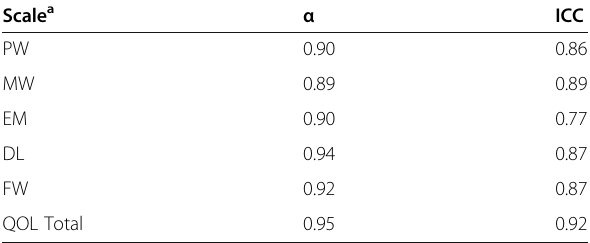
Table 5 Internal consistency (Cronbach ’ s alpha, α ) and test- retest reliability (intraclass correlation coefficient, ICC) Scale a α ICC PW